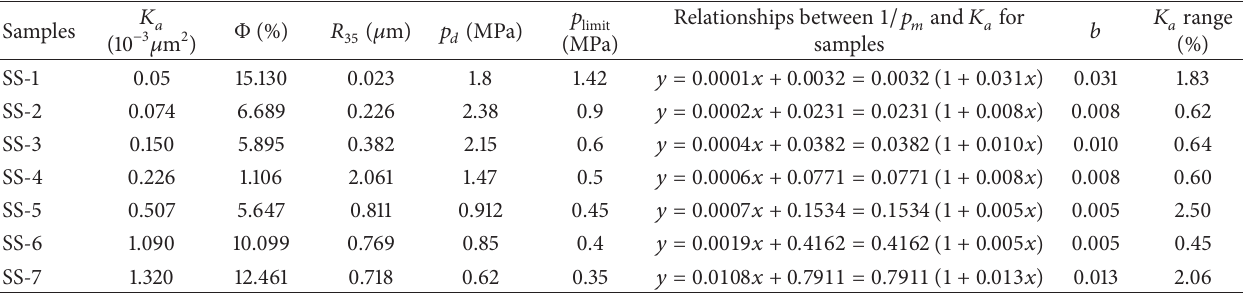
Table 2: Basic parameters of core samples.